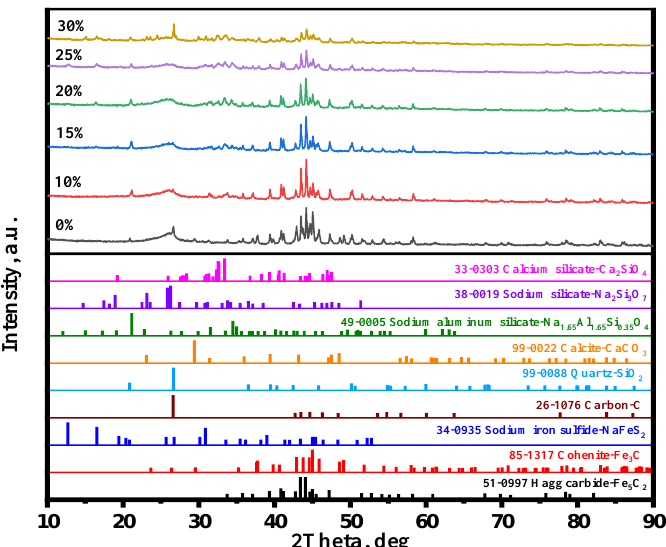
Figure 5. XRD patterns of carburized pellets with various Na 2 SO 4 weight percentages.